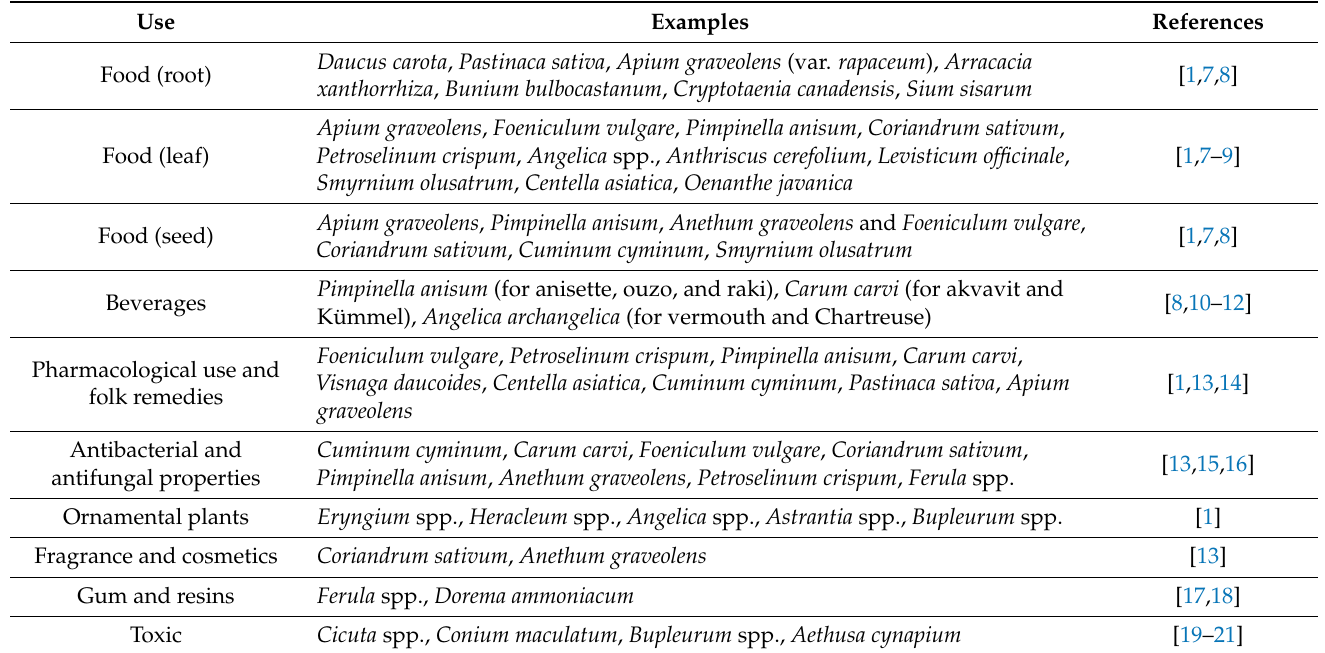
Table 1. Main uses of Apiaceae species in the agrifood and biopharmaceutical